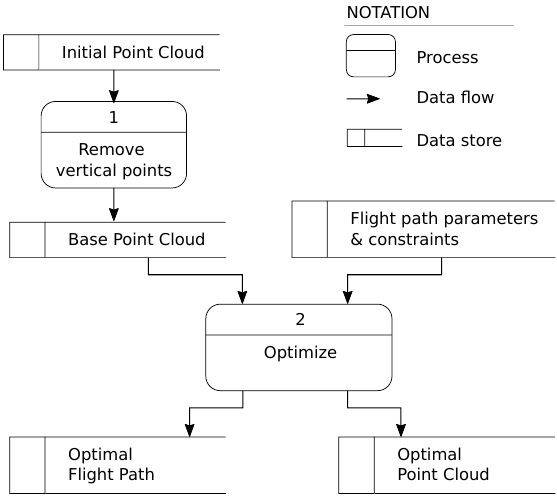
Figure 2. Flow chart showing the data flow and processes in this